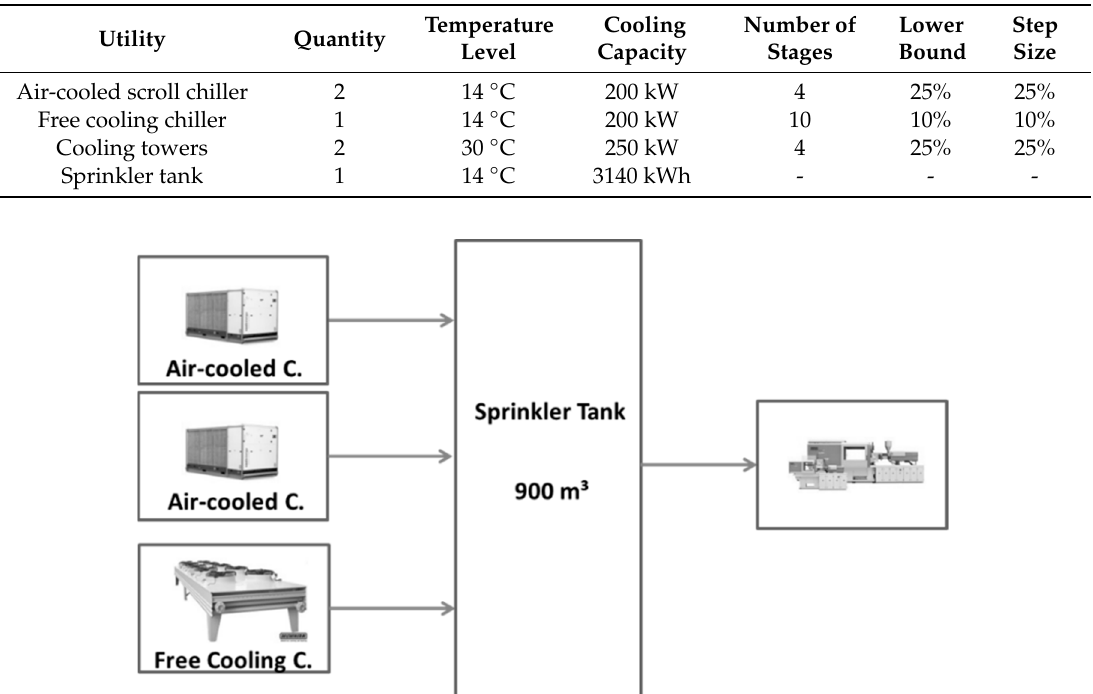
Table 1. Utility system of the plastic processing company.